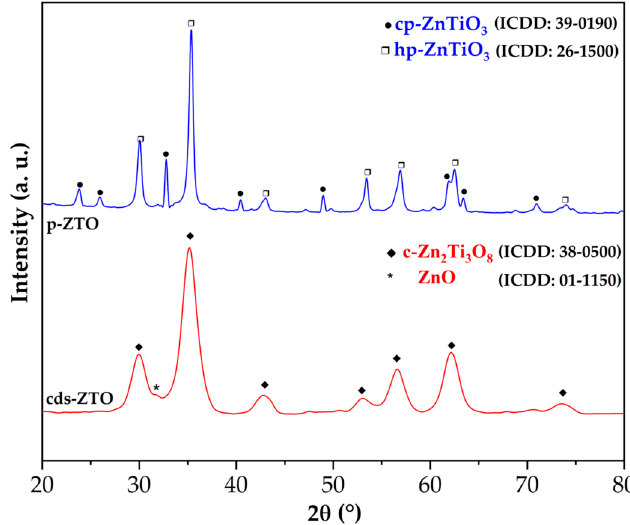
Figure 2. X-ray diffraction patterns of zinc titanates (ZTO) synthesized by cds-ZTO ( bottom ) and p-